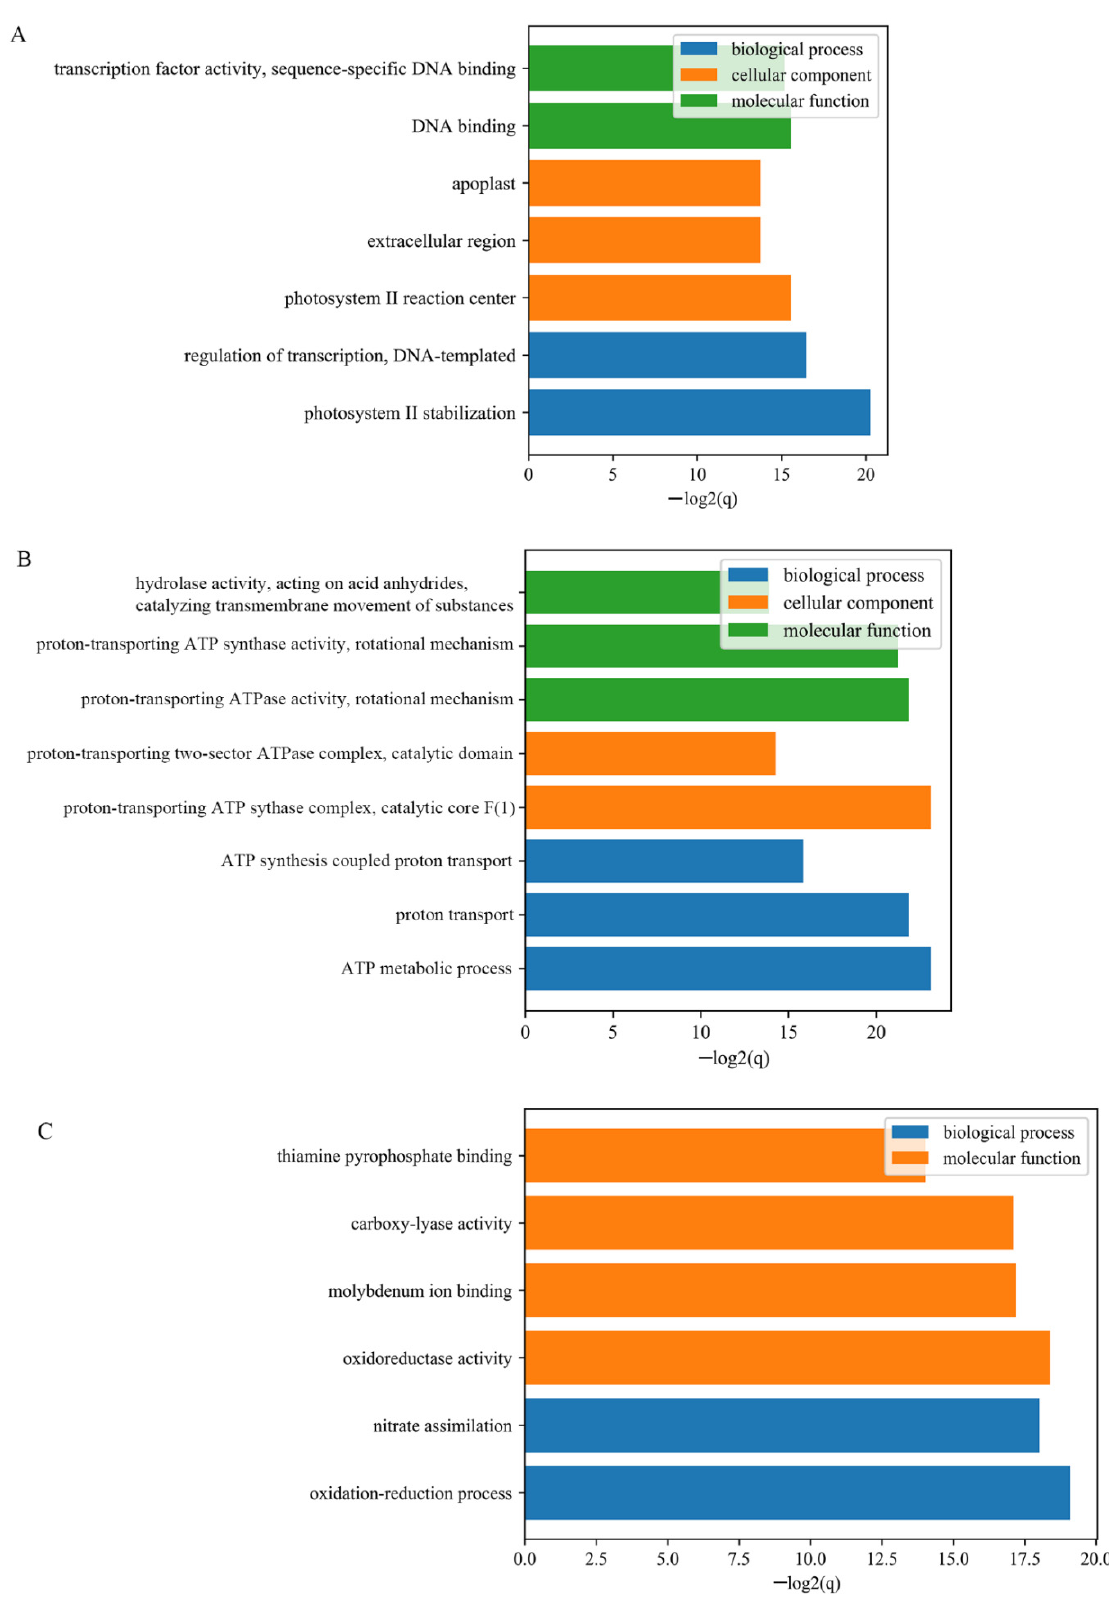
Figure 3. GO enrichment analysis of DEGs at three fiber developmental stages; ( A ), DEGs detected from 1DPA; ( B ), DEGs detected from 1DPA; ( C ) DEGs detected from 1DPA.